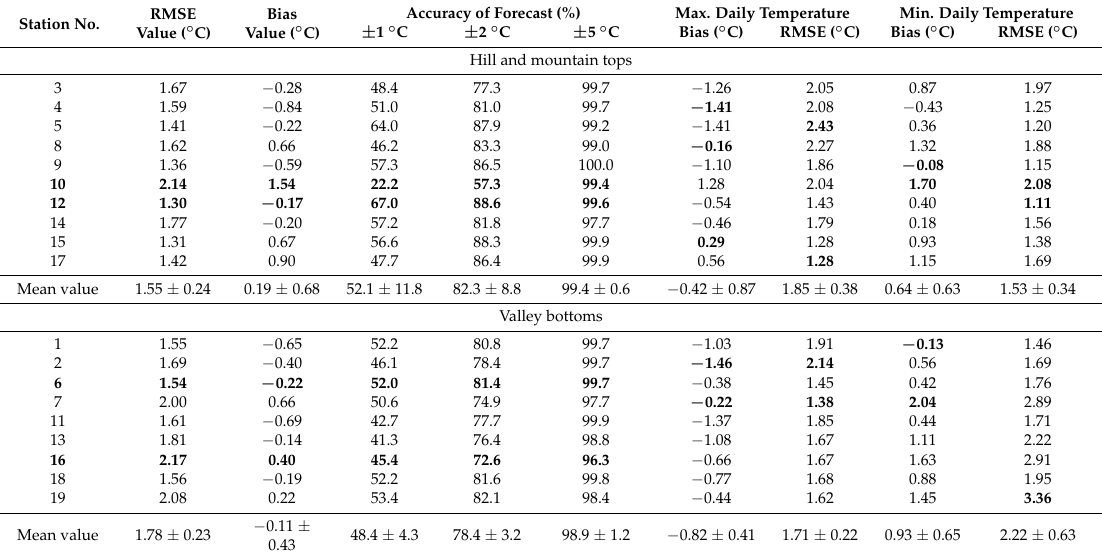
Table 8. Verification of air temperature forecast for period 1 September to 31 December 2017. Station No.